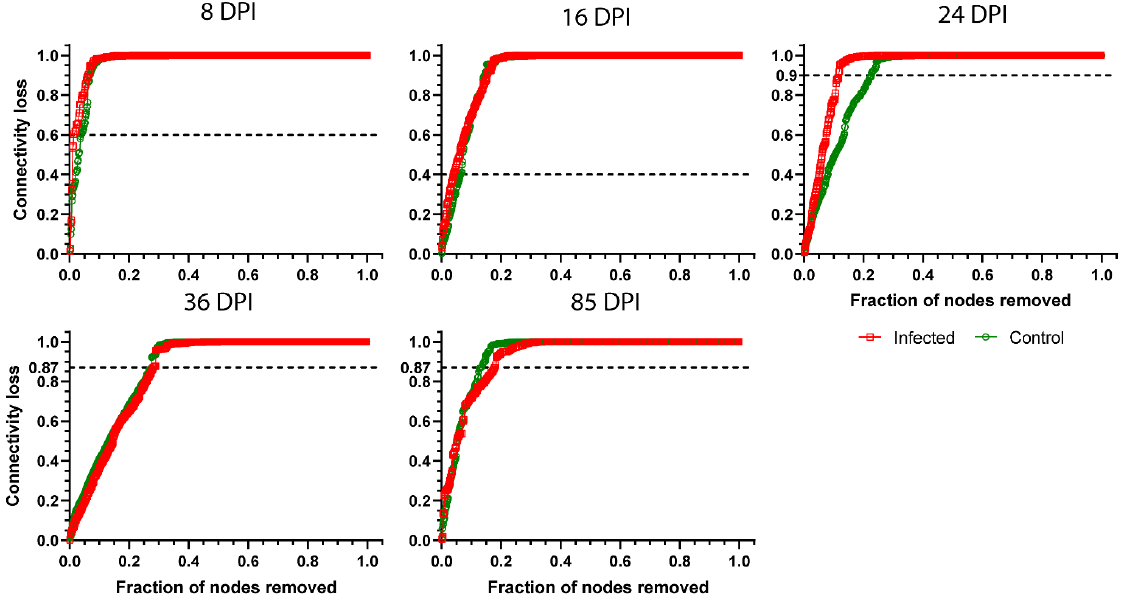
Figure 6. Network tolerance to directed attack. Values of connectivity loss in P. homocircumflexum -infected (red squares) and control (green circles) birds at different days of experiment were compared. At each sampling day a threshold (dashed lines) for connectivity loss was determined where the difference of removed nodes between the infected and control group was the largest.